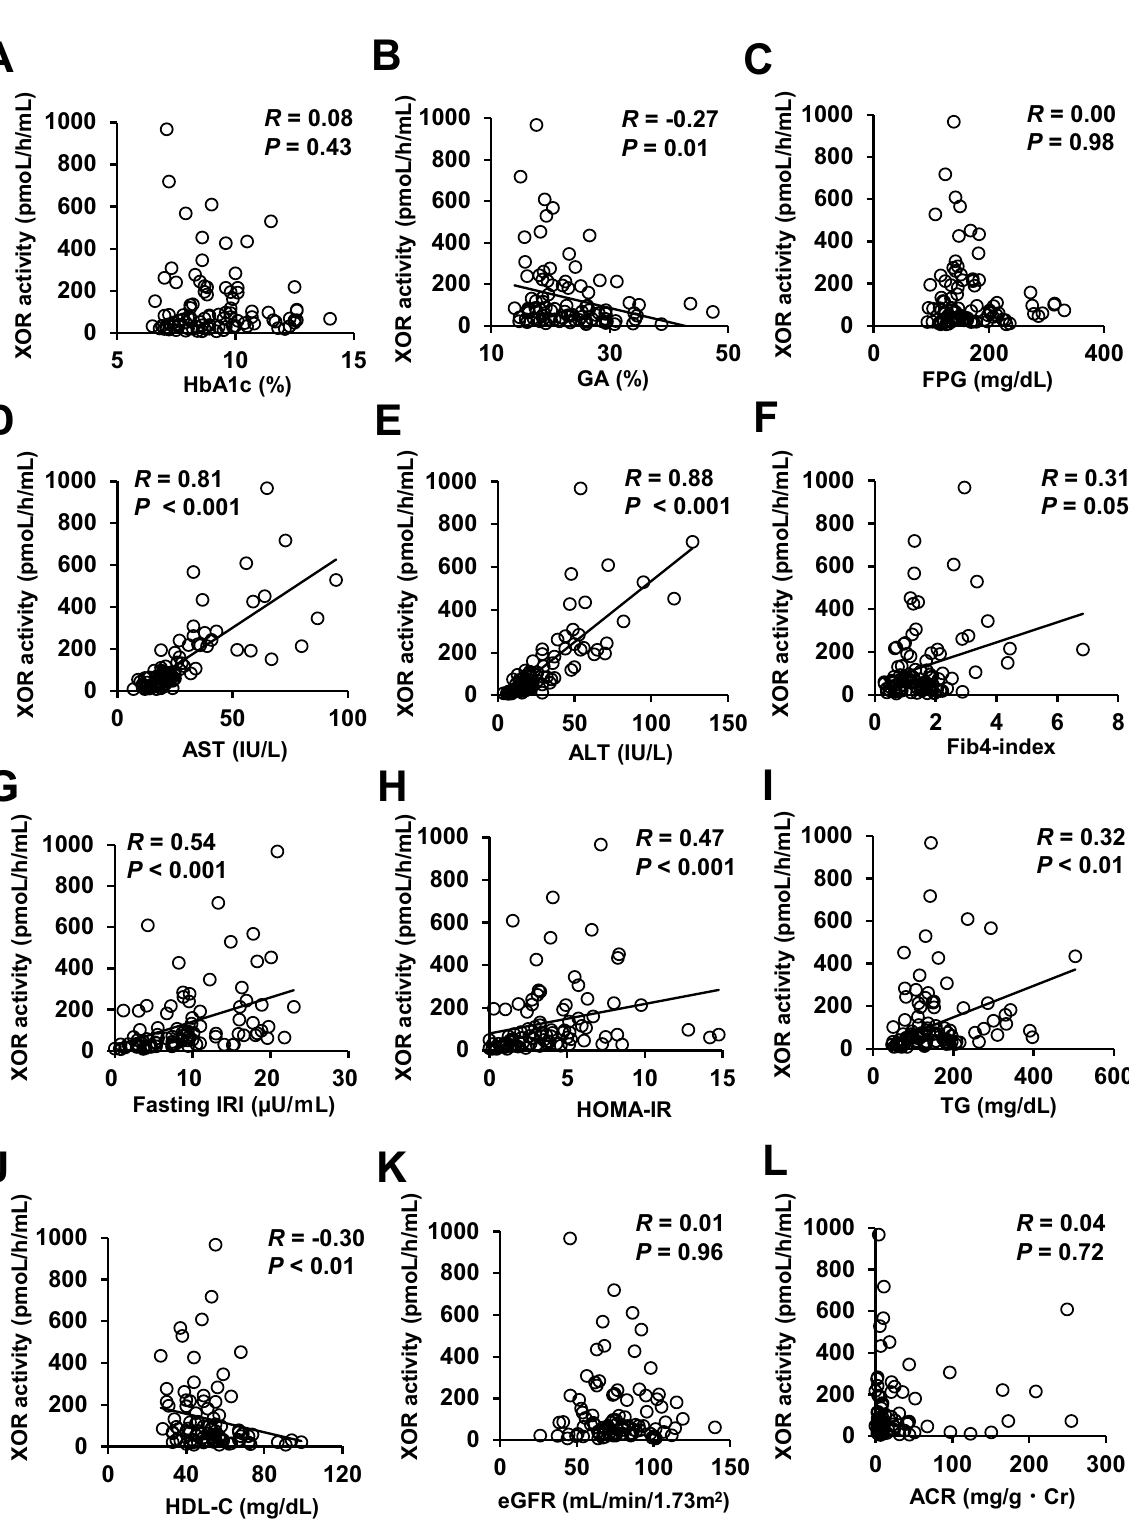
Figure 2. Correlations between the plasma XOR activity level and clinical parameters. Correlations between the plasma XOR activity (pmol/h/mL) and ( A ) HbA1c (%), ( B ) glycated albumin (%), ( C ) fasting plasma glucose level (mg/dL), serum levels of ( D ) AST (IU/L) and ( E ) ALT (IU/L), ( F ) Fib4-index, ( G ) fasting serum IRI (µU/mL), ( H ) HOMA-IR, ( I ) serum TG level (mg/dL), ( J ) HDL-C (mg/dL), ( K ) eGFR (ml/min/1.73m 2 ), and ( L ) urinary albumin to creatinine ratio (ACR) (mg/g ·